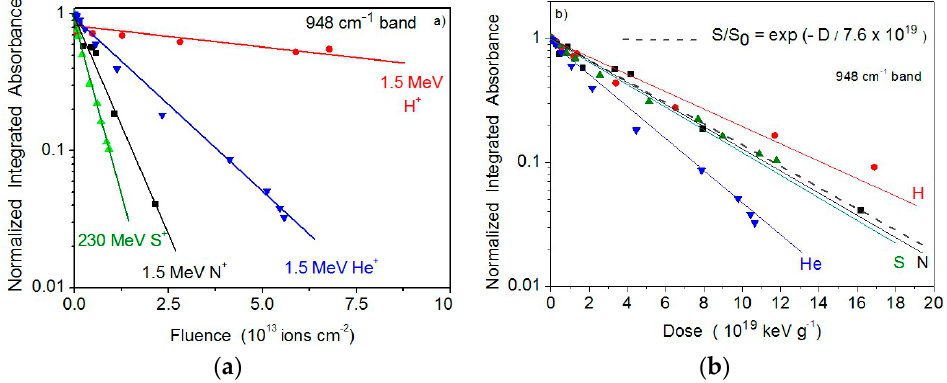
Figure 12. ( a ) Evolution of the 948 cm − 1 band integrated absorbance on fluence for H, He, N and S ion beams. In semi-log plot, angular coefficients represent cross sections. Integrated absorbances have been normalized to 1 at F = 0. ( b ) Same data, but plotted as a function of the absorbed dose.